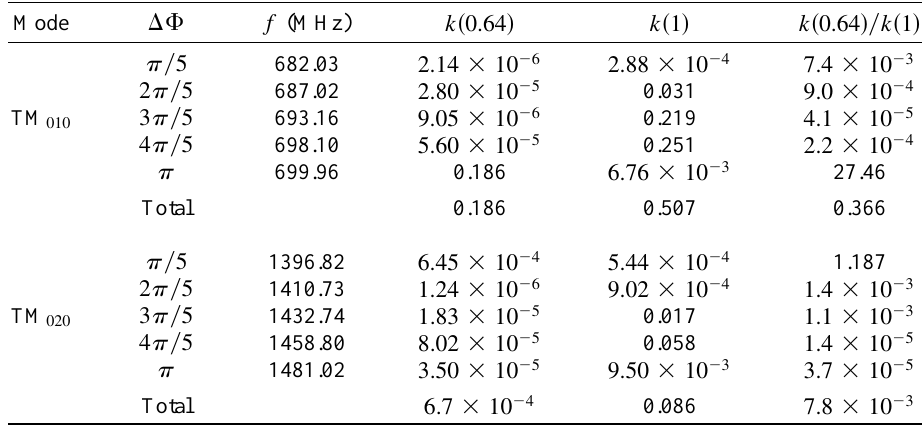
TABLE I. Loss factors (in V (cid:121) pC) of the lowest modes in the APT 5-cell b (cid:173) (cid:48)(cid:46)(cid:54)(cid:52) cavity. Mode DF